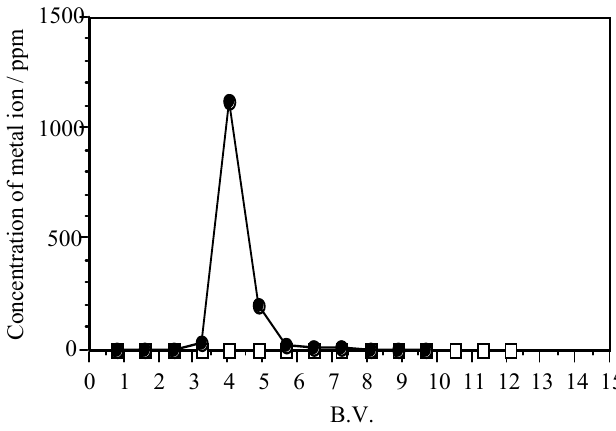
Figure 17. Pb(II) and Zn(II) elution profiles for a column saturated with Pb(II) ions and eluted with 1 M nitric acid solution at a flow rate of 5.5 mL/h [14]. (Copyright 2003 by The Minerals, Metals & Materials Society. Reprinted with permission).